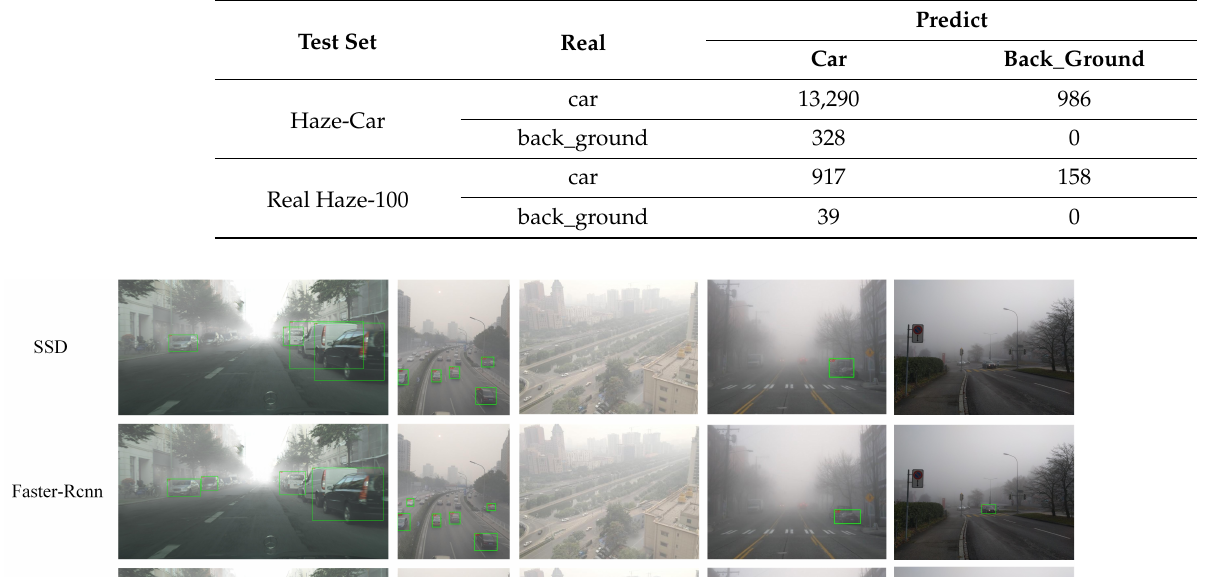
Figure 6. Training process and loss changes. Table 2. Confusion matrix of test sets Haze-Car and Real Haze-100.